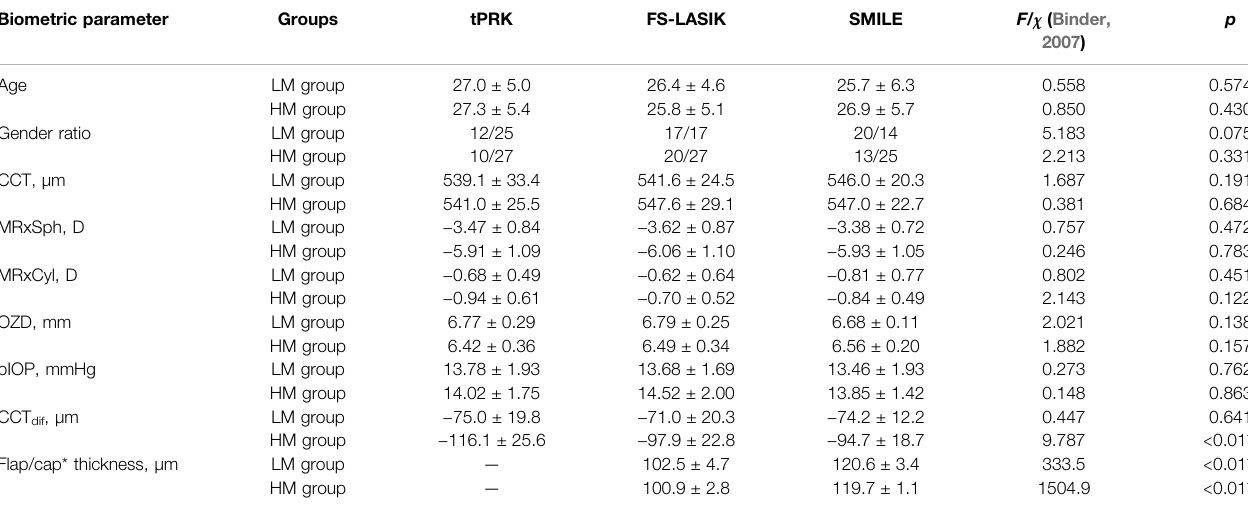
TABLE 1 | Basic information for the three surgery groups.